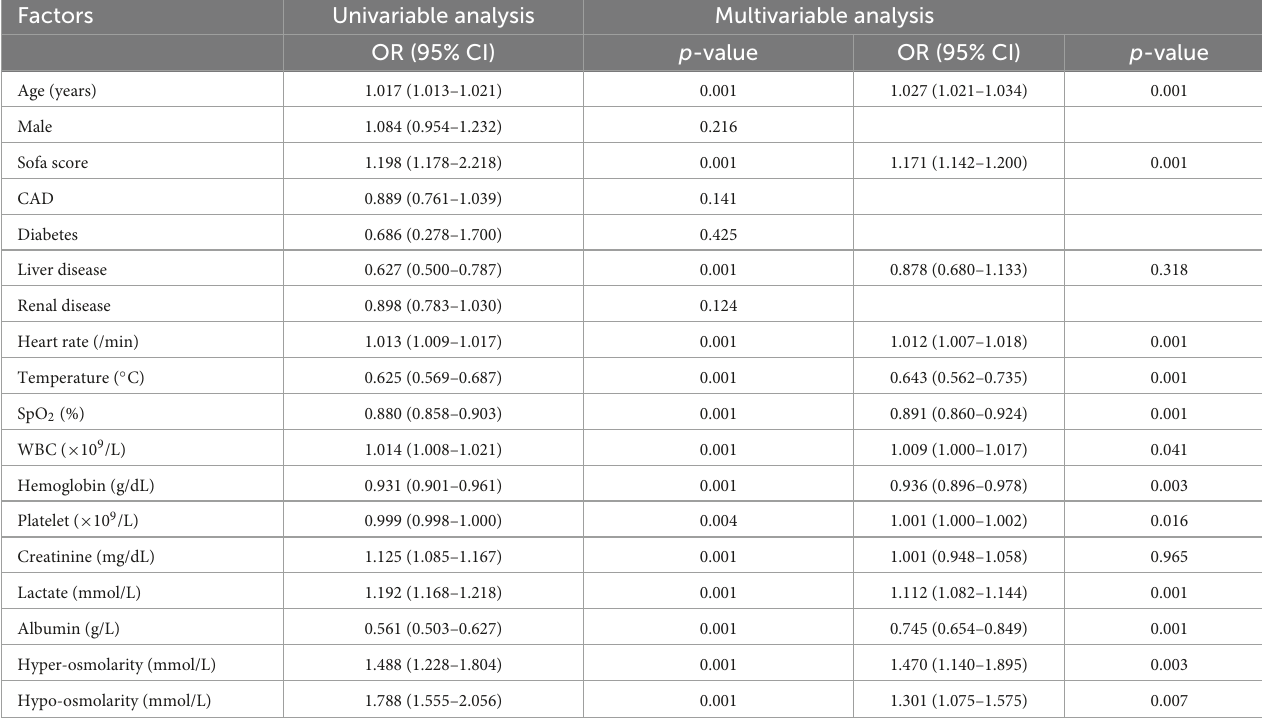
TABLE 4 Univariable and multivariable analysis of risk factors associated with ICU mortality before PSM.